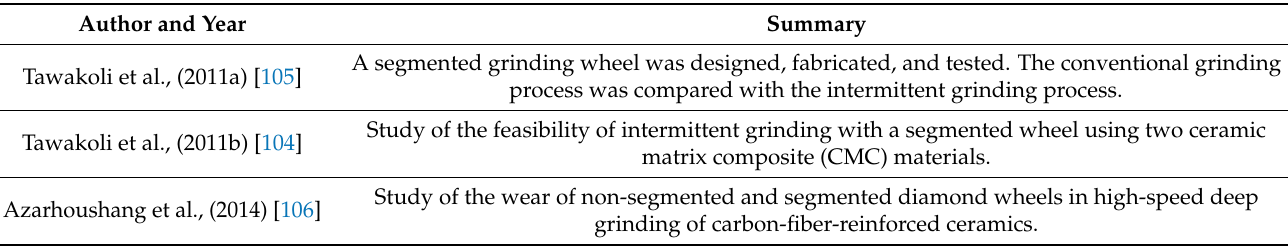
Table 9. Summary of the works on segmented grooves.